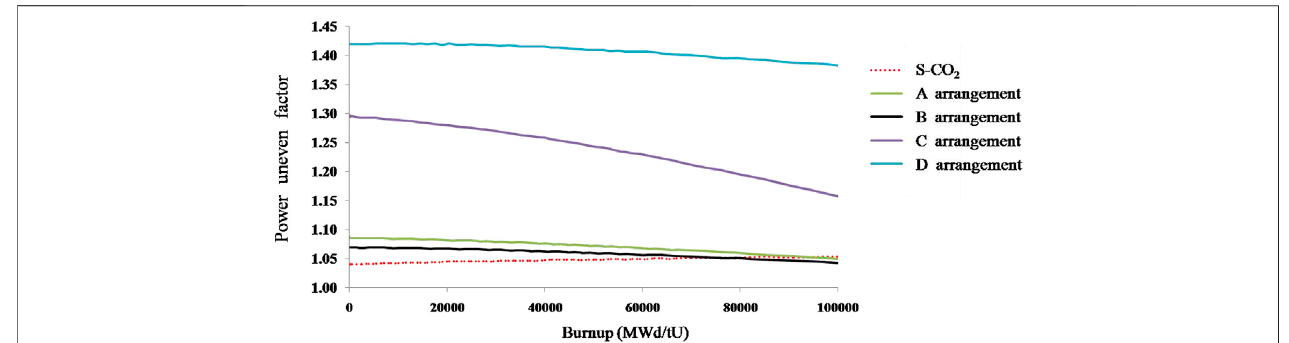
FIGURE 10 | Power uneven factor by different solid moderator